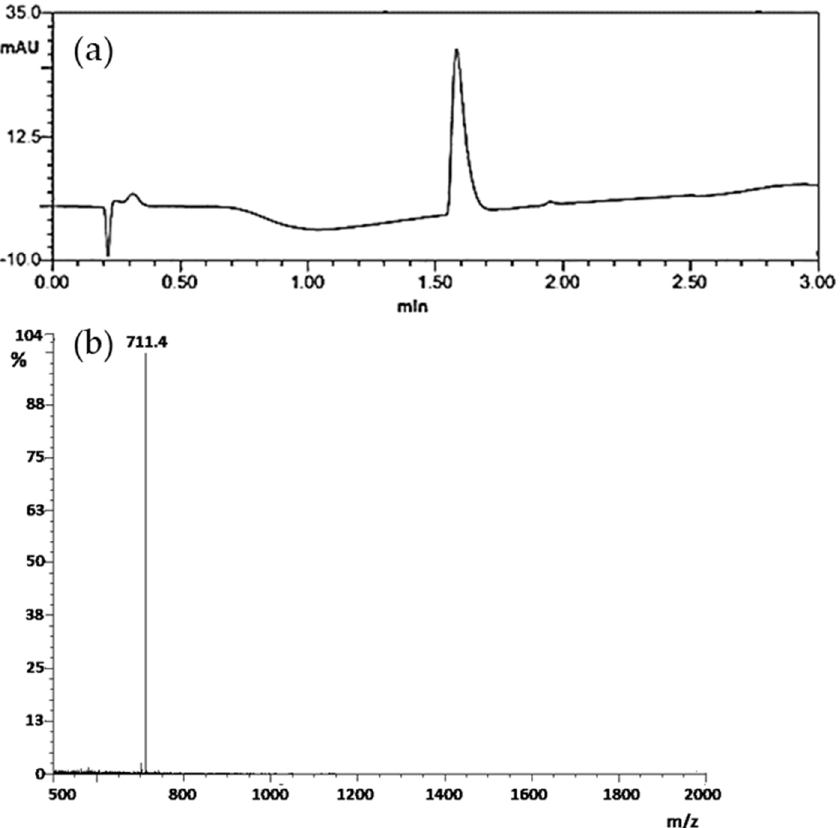
Figure 2. ( a ) High-performance liquid chromatography (HPLC) chromatogram of Tyr-PEG 2 -RM26 at 280 nm and ( b ) mass spectrum of Tyr-PEG 2 -RM26.